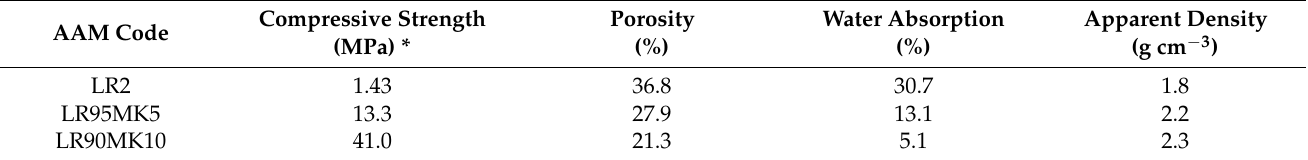
Table 4. Porosity, water absorption, and apparent density of selected AAMs.